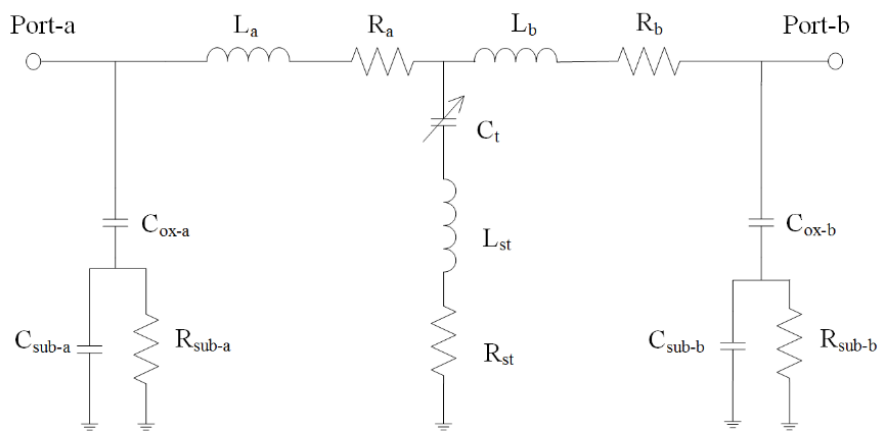
Figure 5. Equivalent circuit.